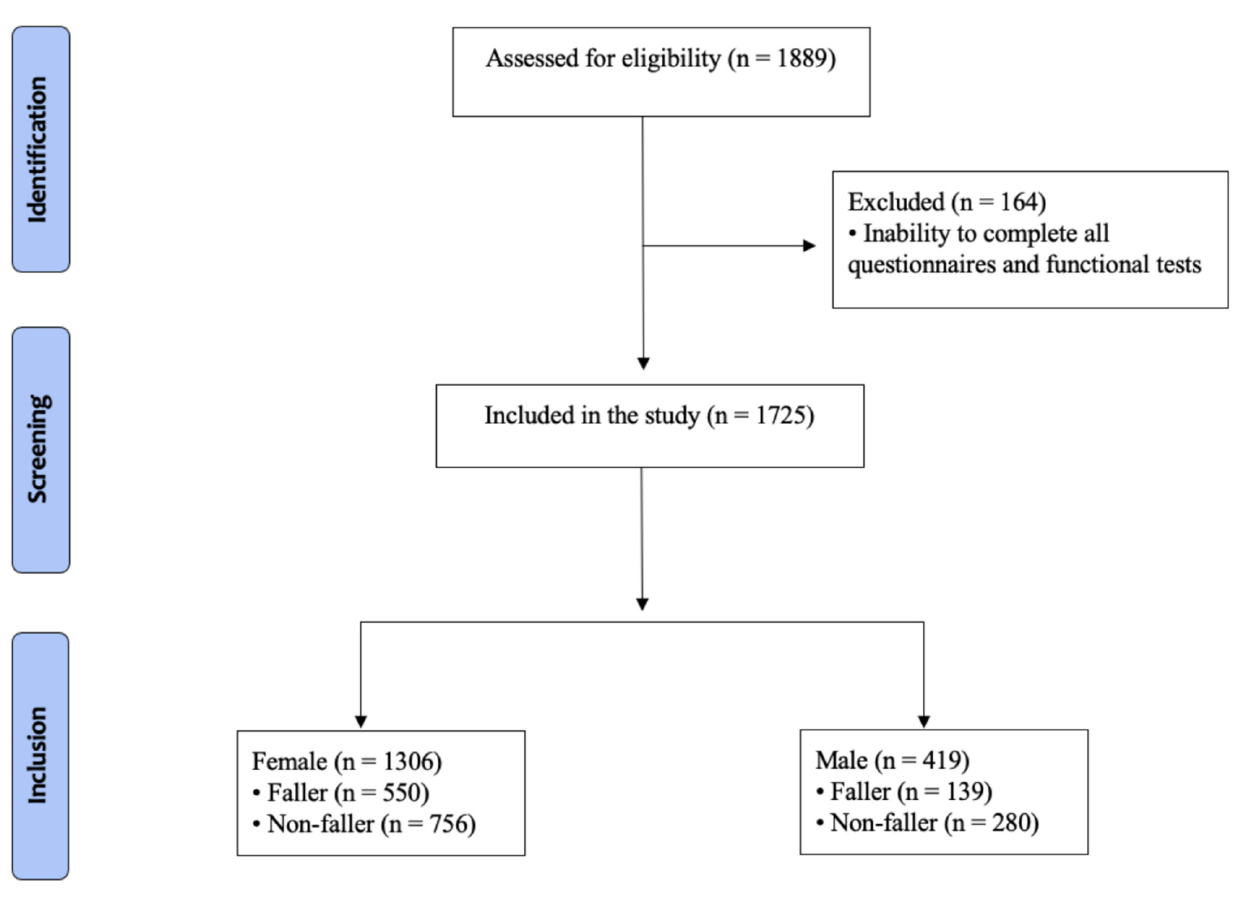
Figure 1. Flow Figure 1. Flow chart.